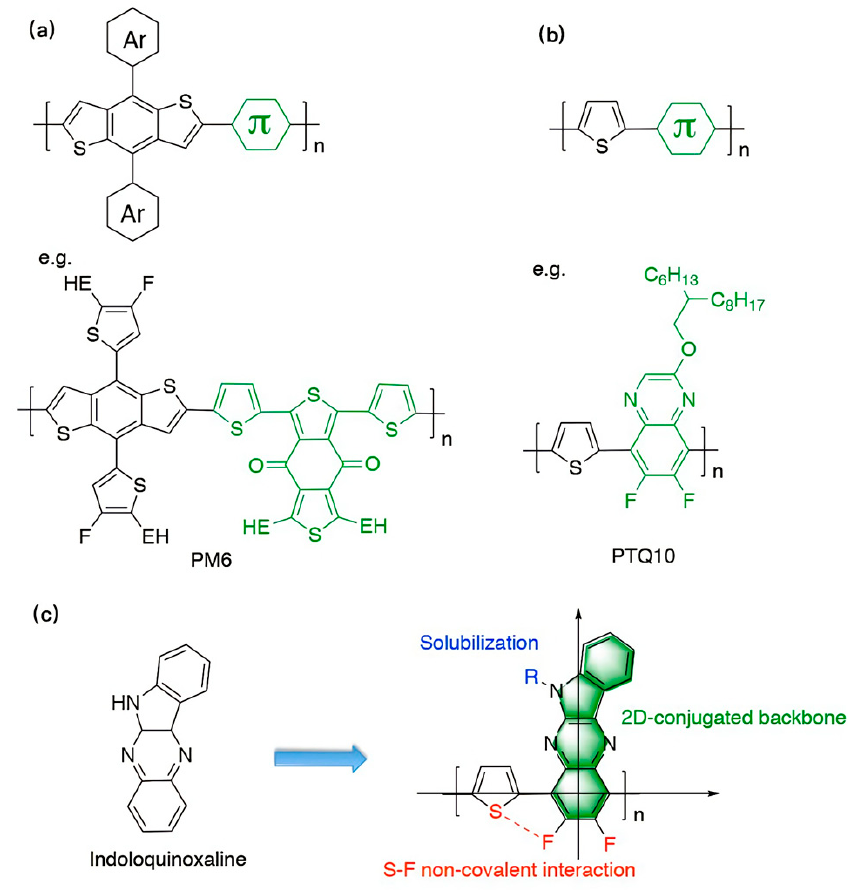
Figure 1. ( a ) BDT-based and ( b ) thiophene-based polymer donors; ( c ) molecular design strategy of the indoloquinoxaline-based polymer.